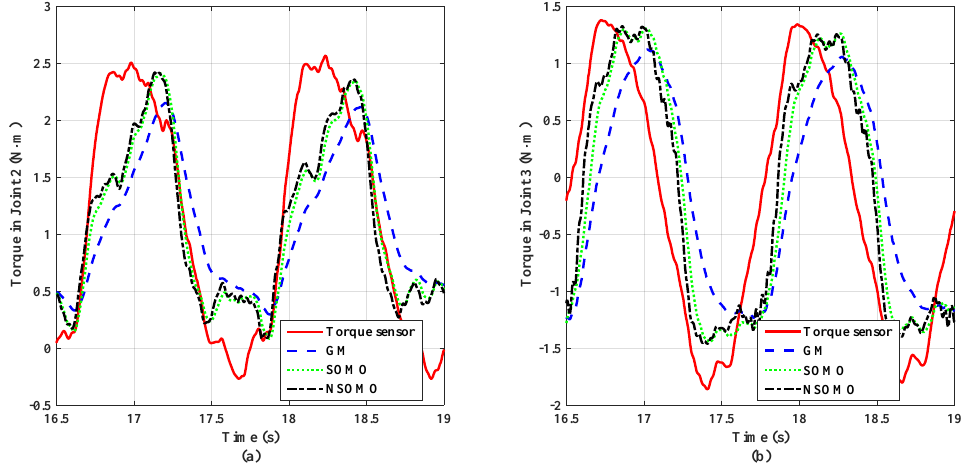
Figure 13. Comparison results of three observers and torque sensors in scenario B. ( a ) Joint 2; ( b ) Joint